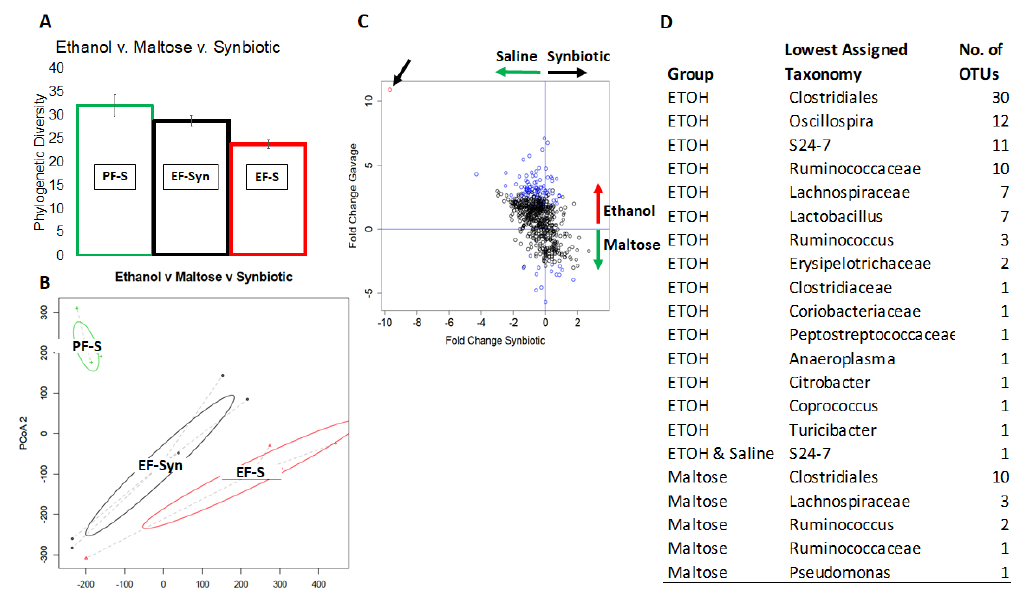
Figure 1. The effect of ethanol and synbiotic on the microbiota. Mice were fed a liquid diet containing ethanol (5% v / v ) or pair-fed a diet with maltose dextrin isocalorically substituted for ethanol for 10 days. Mice were randomized into groups and supplemented with a butyrate-targeting synbiotic or saline. On day 11, mice were treated with a single 5 g/kg gavage of ethanol. At 6 h post-gavage, the cecum was dissected and flash frozen and kept at −20°C until analysis (see methods). ( A ) Ethanol exposure decreased the overall phylogenetic diversity of the cecal microbiota ( p = 0.001), which was partially recovered by synbiotic supplementation; ( B ) ethanol significantly altered microbiota community composition and structure, as assessed by a weighted UniFrac analysis followed by PERMANOVA ( p = 0.007). The ethanol-synbiotic group clusters away from animals only receiving ethanol indicated some recovery, but the difference was not significant; ( C) differential abundance analysis, executed as a negative binomial Wald test, revealed operational taxonomic units (OTUs) significantly enriched in either the maltose or ethanol groups (blue circles) or both ethanol and saline (red circle); ( D ) list of microbial taxa enriched in either the maltose, ethanol, or saline groups. n = 4-6 mice per treatment group.